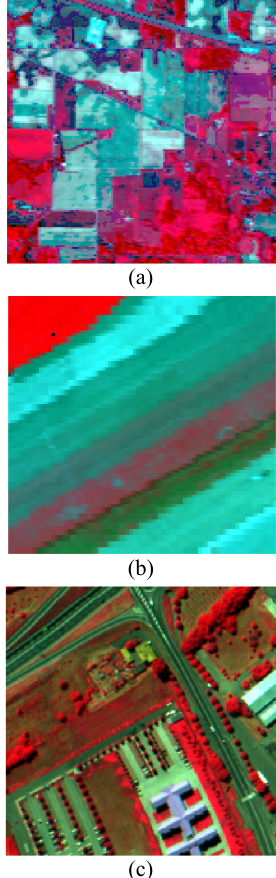
Figure 1. FCC of (a) Indian Pines (R: 57, G: 27, B: 17), (b) Salinas-A (R: 57, G: 27, B: 17), and (c) University of Pavia (R: 102, G: 56, B: